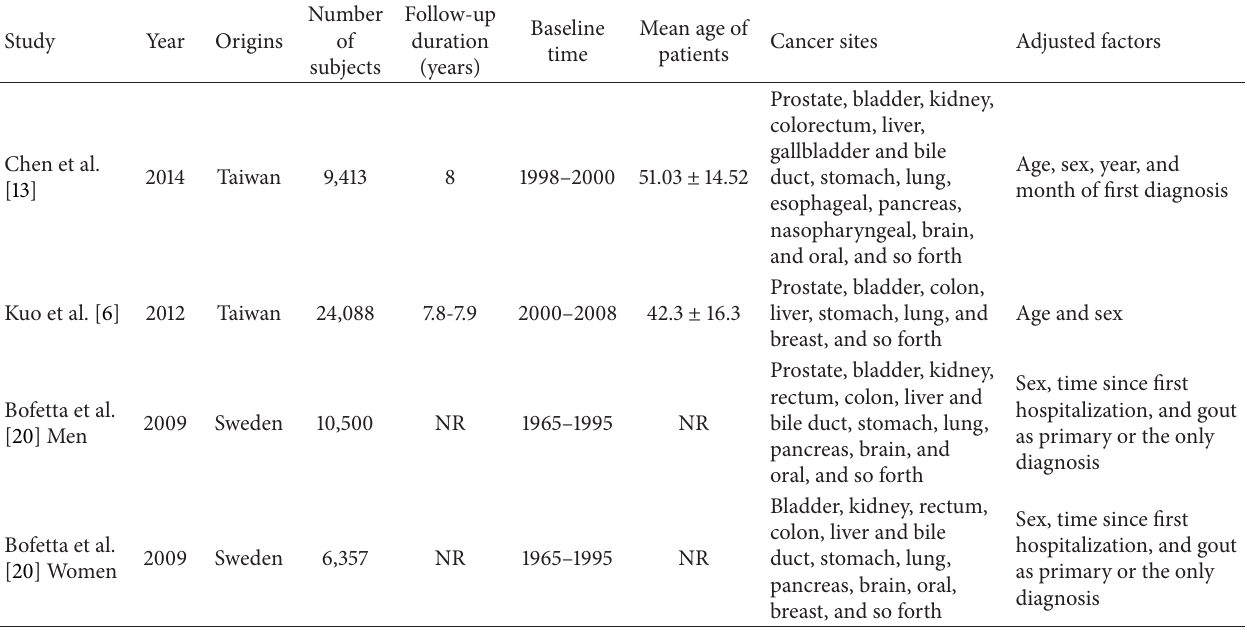
Table 1: Characteristics of all studies.